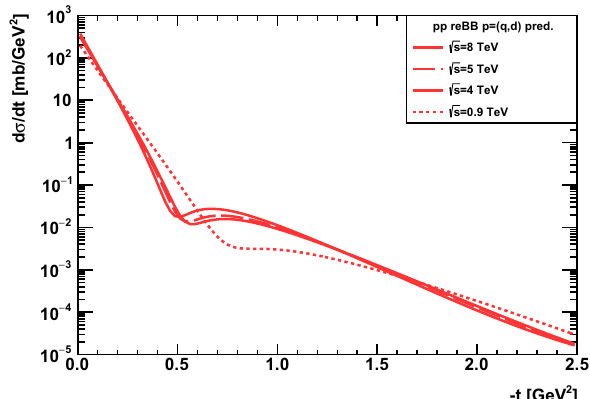
Fig. 19 Predictions from the ReBB model, for the d σ/ dt of elastic pp √ s = 8, 5, 4, and 0.9 collisions at